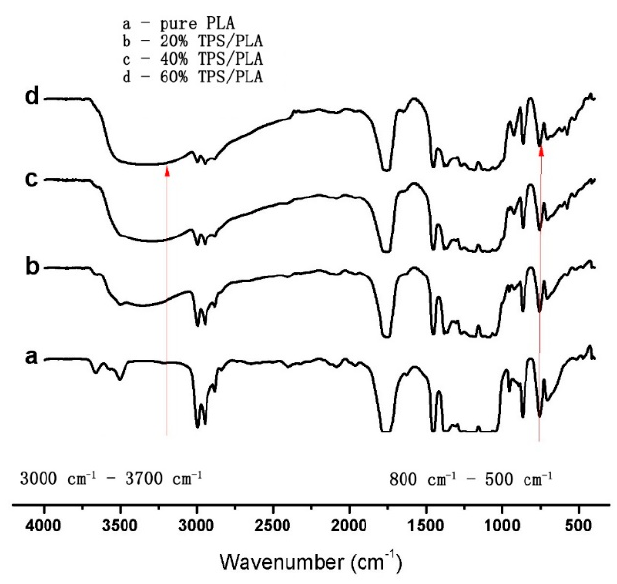
Figure 5. FTIR spectra of TPS/PLA blend.